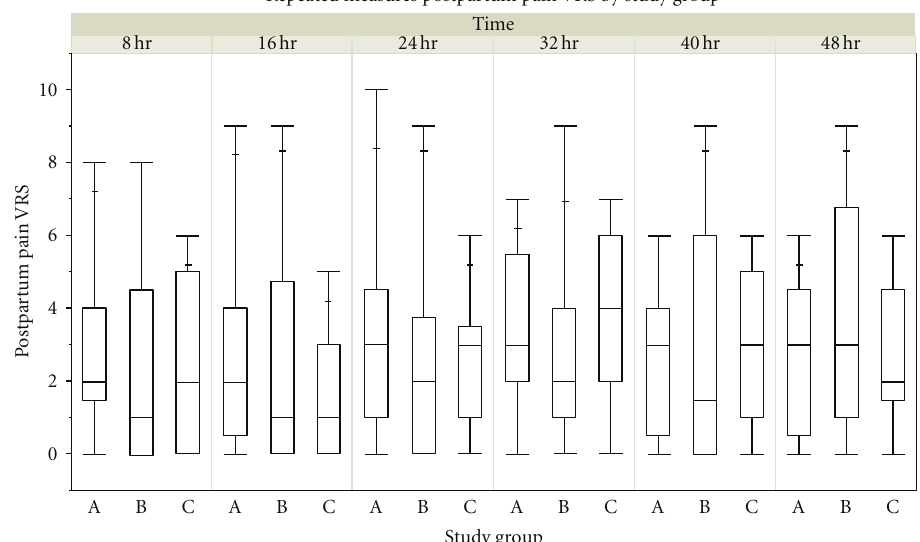
Figure 4: Median pain scores over the measured time periods. Quantile boxplot display of postpartum pain VRS by study group.